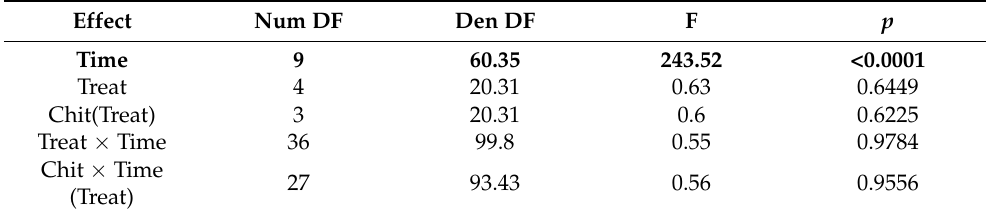
Figure 5. Mean variation by time of the cumulative germination of the seed of onion. Nor the Ethylene application or chitosan showed to affect the regression, thus, raw data (white circles) per sampling occasion were used. Red triangle indicate the LSmeans p-difference separation of the Time effect in Table 3 computed and separated by a conservative Tukey − Kramer grouping at the 5%. LSMeans with a letter in common should not be considered different according to Tukey − Kramer. Data are arithmetic means and standard errors ( n = 4). The model fitted is indicated with a solid black line and prediction intervals at the 95% were shown (gray dashed lines). The sigmoid function fitted to the time variation is shown as a pic title and its coefficient embedded. Analysis of the sigmoidal function fitted is reported in Table 4. Table 3. F and p -values of the general linear mixed model applied to the temporal trend of the cumulative germination of onion seed. Factors were the time (referred as “Time” and included as a class variable), the moment and amount of ethylene applied [Treat] and the Chitosan nested in the ethylene application [Chit(Treat)] and interaction terms [Treat × Time, and Chit × Time (Treat)]. Values at p < 0.05 were indicated in bold. Numerator degrees of freedom are indicated, denominator degrees of freedom were estimated by the Kenward Roger